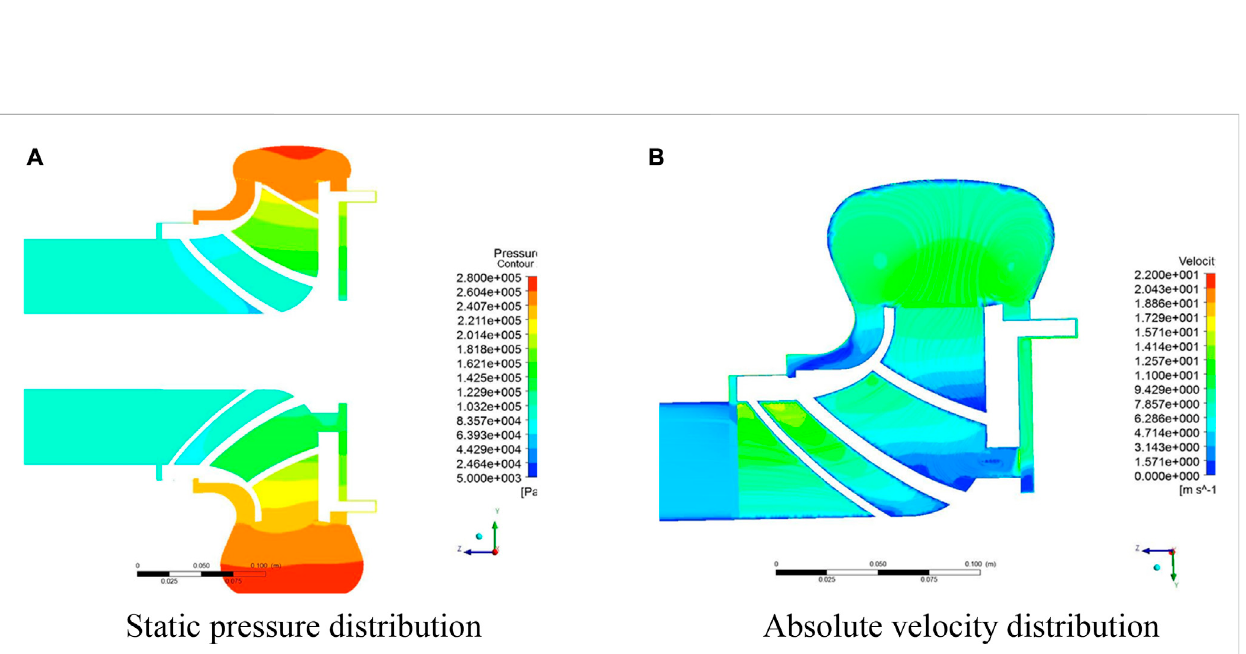
point, and about 2.5% lower at the off-design operating point. Therefore, the double volute chamber has a wider range of high ef fi ciency and is suitable for operation under variable conditions.